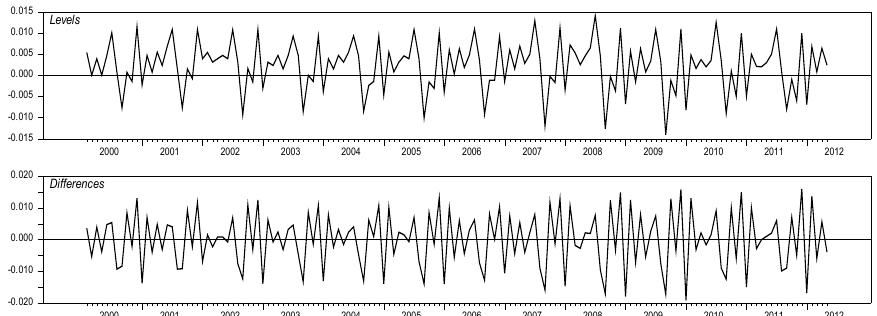
Figure 9. Eurozone price index in the hospitality industry 𝐼(1) . Data vector January 2000 to May 2012 (Great Depression).